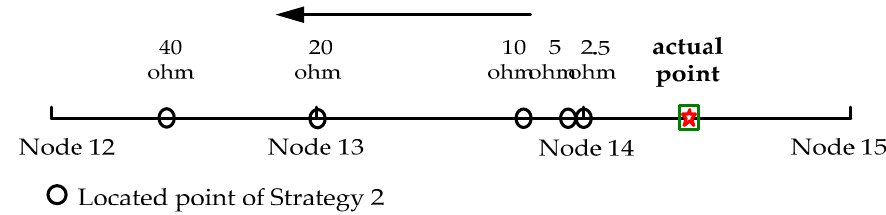
Figure 7. Located points of Strategy 2 with the change of fault resistance.